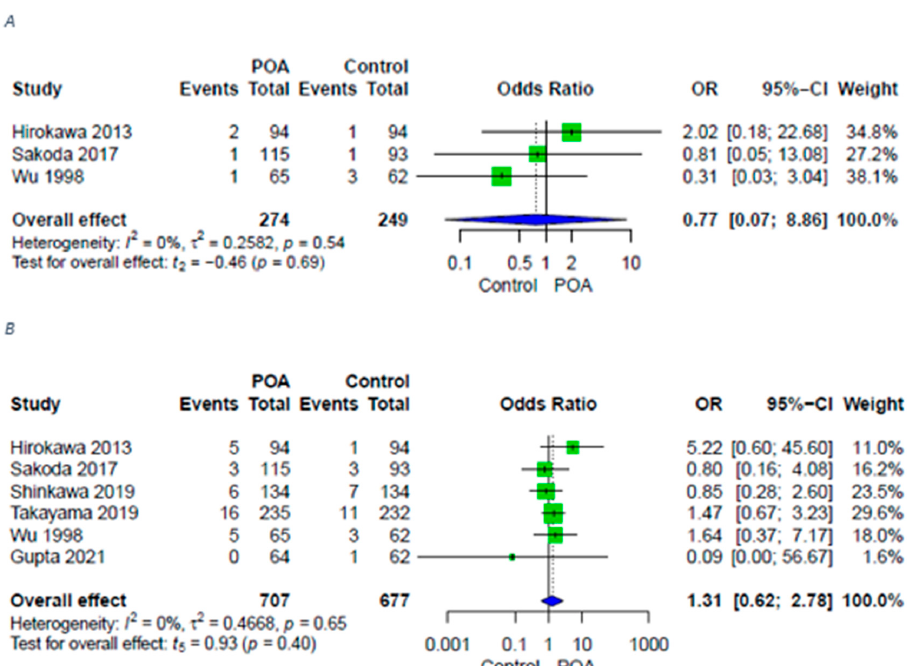
Figure 5. Forest plots for liver specific complications in patients with POA versus control. ( A ) Forest plot for PHLF in patients with POA versus control; ( B ) Forest plot for bile leakage in patients with POA versus control. A random-effects model was utilized for all outcomes due to heterogenic methodological and clinical framework of included studies. Statistical heterogeneity was evaluated using the I 2 statistics. An I 2 value below 25% indicated low heterogeneity, while over 75% was considered high.